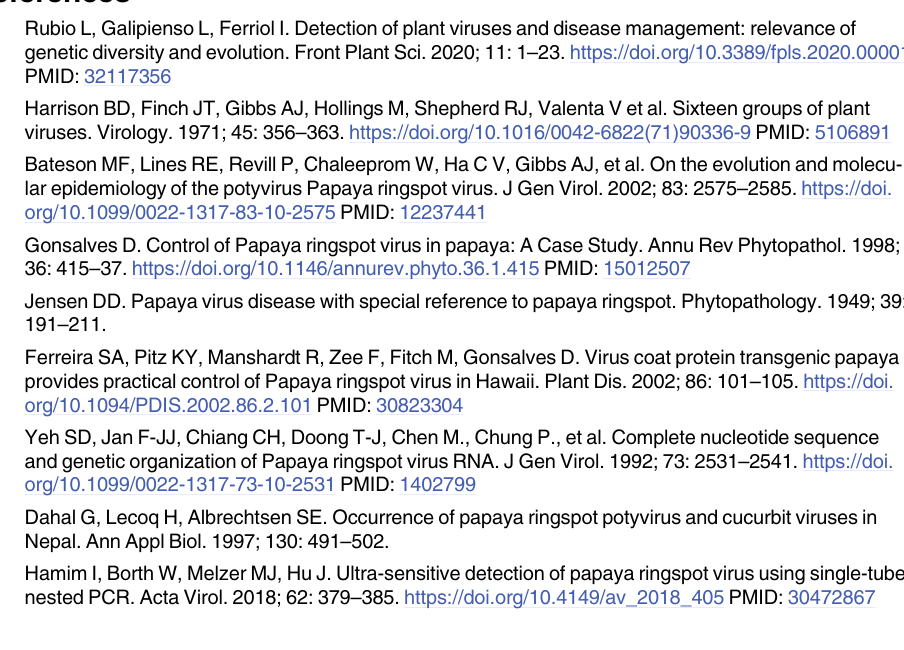
S2 Fig. Region-specific Neighbor-Joining tree representing the phylogenetic relationship between complete genome sequences of PRSV-P isolate of Pakistan and PRSV complete genome sequence from rest of the world. Sugarcane mosaic virus (SCMV) (accession no. MN795295) used as an outgroup. The tree was constructed using ClustalX2 and MegaX Pro- gram. The scale bar represents nucleotide substitution per site, the bootstrap value of 1,000.